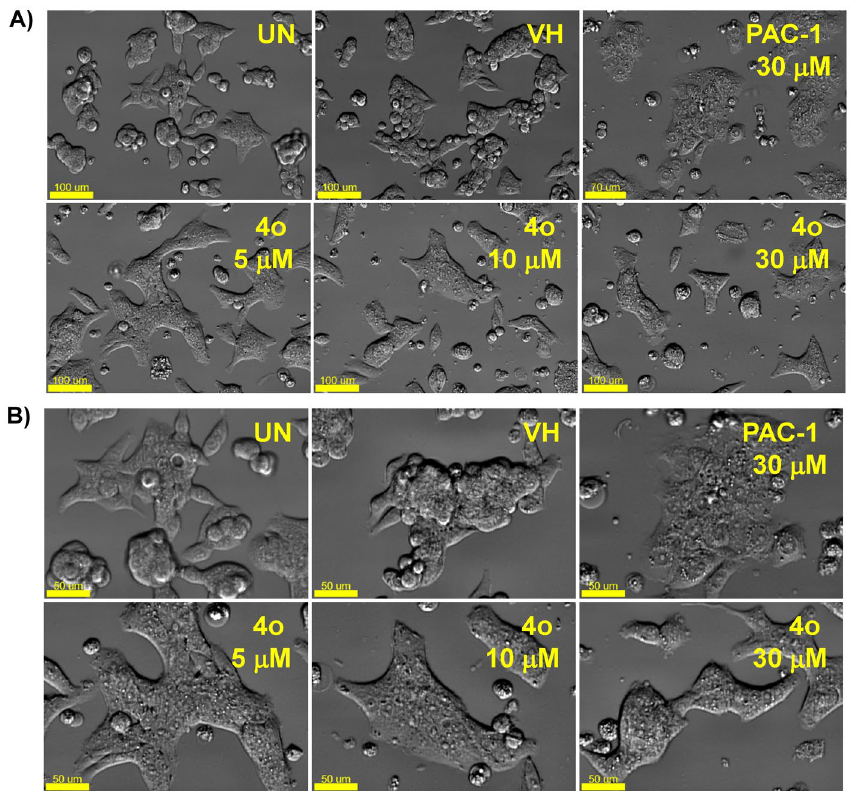
Figure 8. Morphology changes of cells treated with compound 4o or PAC-1. SW620 at 2.5 × 10 5 cells/mL (500 µL in 24 well) were incubated for 24 h and then further treated with 4o (5, 10, and 30 μM) or PAC-1 (30 μM) for 24 h. Cells were photographed using an Imaging Device (Celldiscoverer 7) with ×20 ( A ) and ×40 ( B ) lens. Scale bar: 50 mm. UN untreated, VH vehicle (DMSO. 0.1%). Representative images are